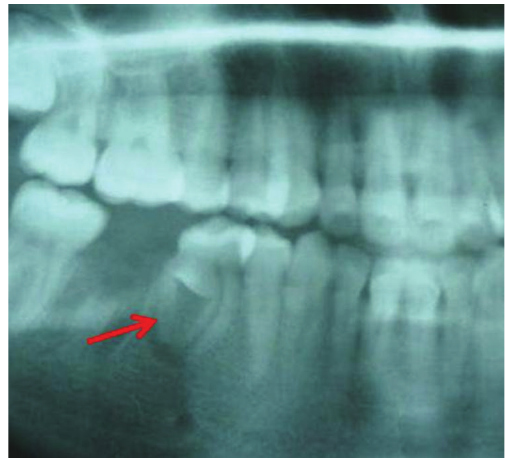
Figure 2: Cropped orthopatomogram showing invagination in root of mandibular right first premolar.